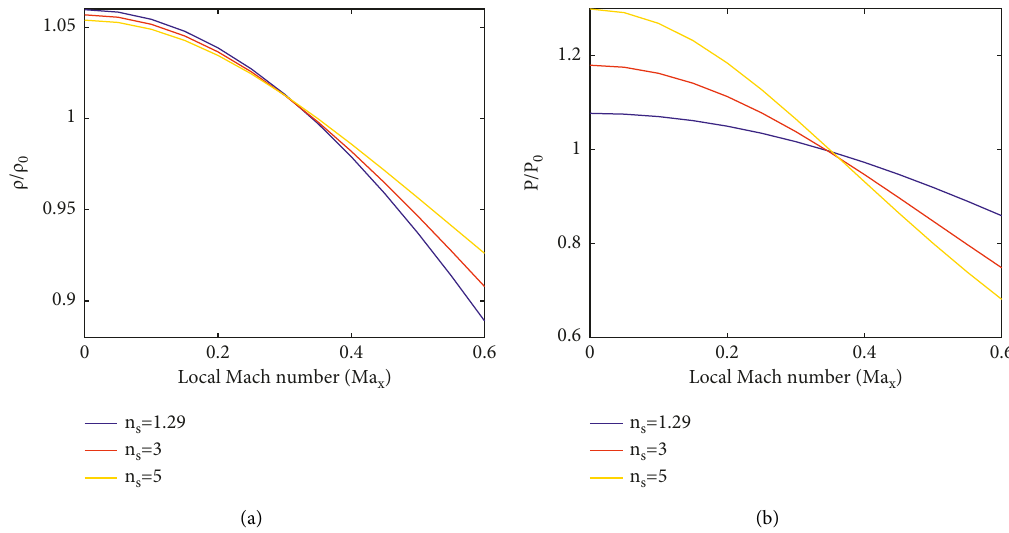
Figure 2: Isentropic exponent effects at the inlet tip of the impeller. (a) Density and (b) pressure.